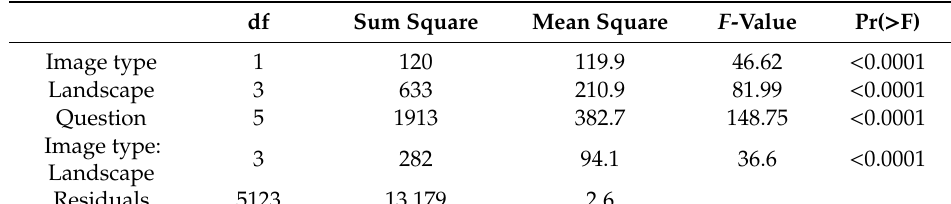
Table 2. Randomized Block ANOVA comparing image types and landscapes for six preference questions (blocks).